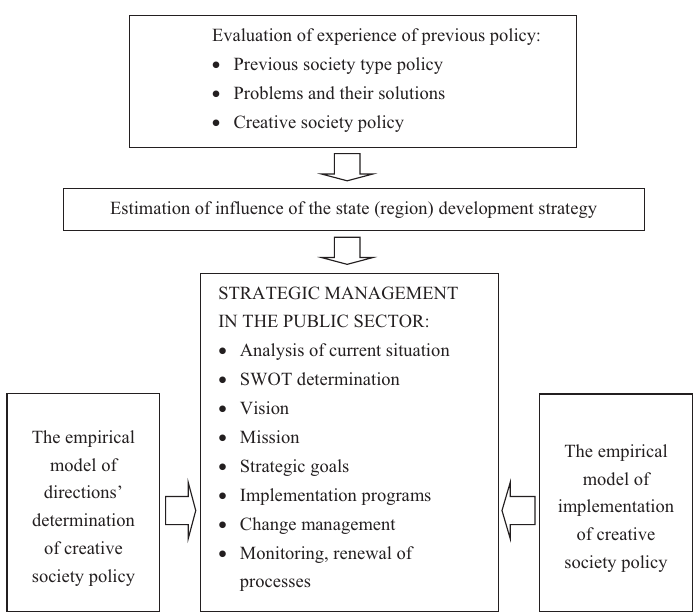
Figure 4. The model of creative society policy (source: created by author)